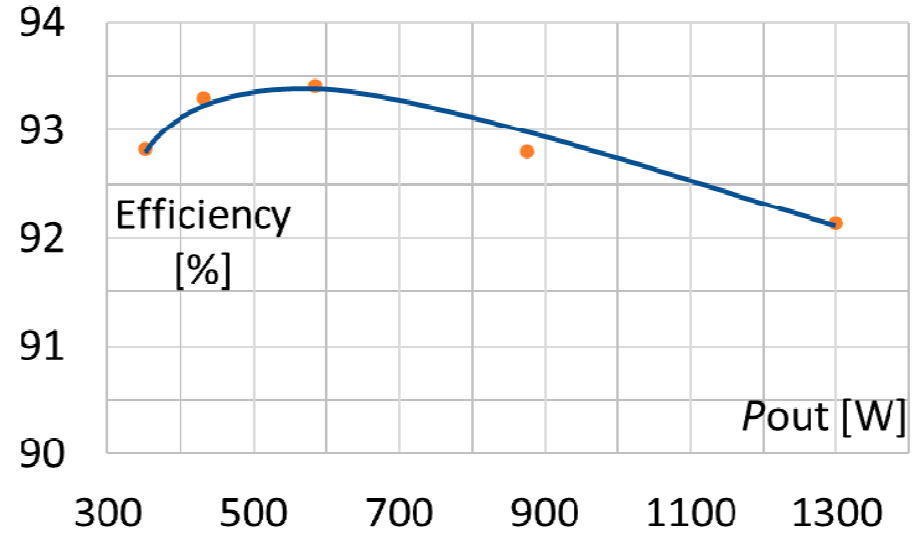
Figure 27. Efficiency of the converter: the AIVB (with TP65H035WS transistors) and the NPC inverter.